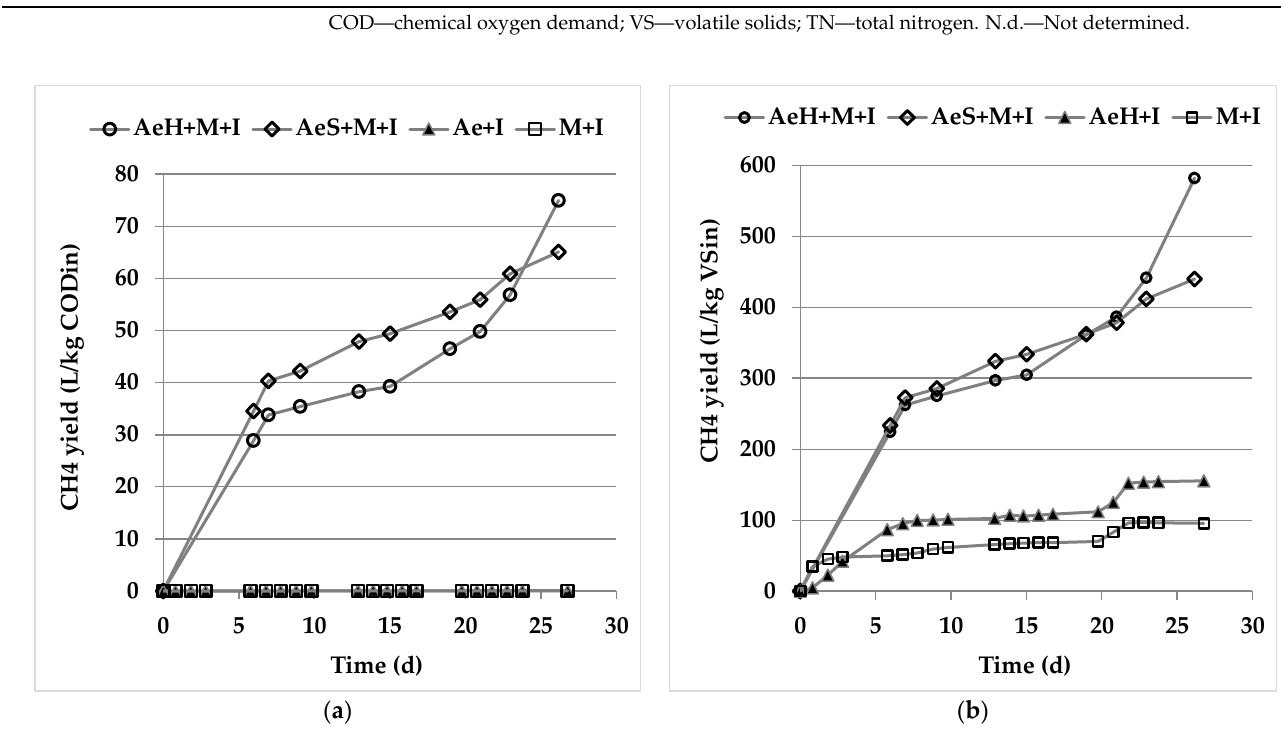
Figure 2. Anaerobic digestion of wastes from fermentation: ( a ) cumulative methane yield expressed as L CH 4 /g COD added at the beginning of the AD; ( b ) cumulative methane yield expressed as L CH 4 /g VS added at the beginning of the AD.